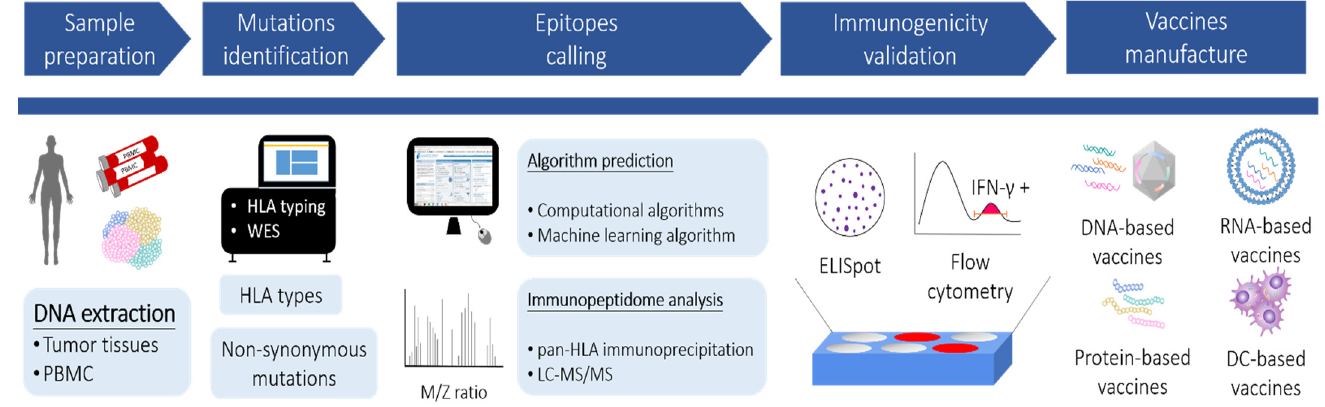
Figure 1. Schematic representation of neoantigen selection for therapeutic cancer vaccines. The DNA samples are extracted from cancer tissues and peripheral blood mononuclear cells (PBMC), respectively. Non ‐ synonymous mutations and HLA types are obtained through whole ‐ exome sequencing (WES) and HLA genotyping following bioinformatic analyses. The potential neoepitopes derived from the identified mutations are prioritized according to (1) algorithm prediction or (2) immunopeptidome analysis. Afterward, each prioritized neoepitope is examined by immunological assays (e.g., ELISpot or flow cytometry) to validate the immunogenicity. Vaccines encoding the selected neoepitopes are then generated in various formats, including DNA ‐ based, RNA ‐ based, peptide ‐ based, and dendritic ‐ cell (DC) ‐ based vaccines.